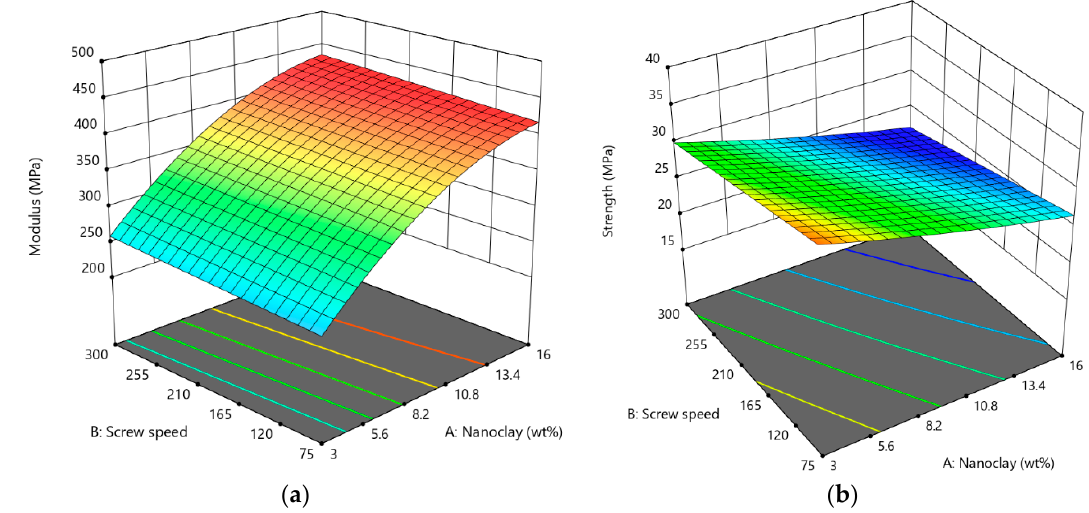
Figure 4. 3D surface plot of ( a ) tensile modulus and ( b ) tensile strength versus screw speed and nanoclay content.